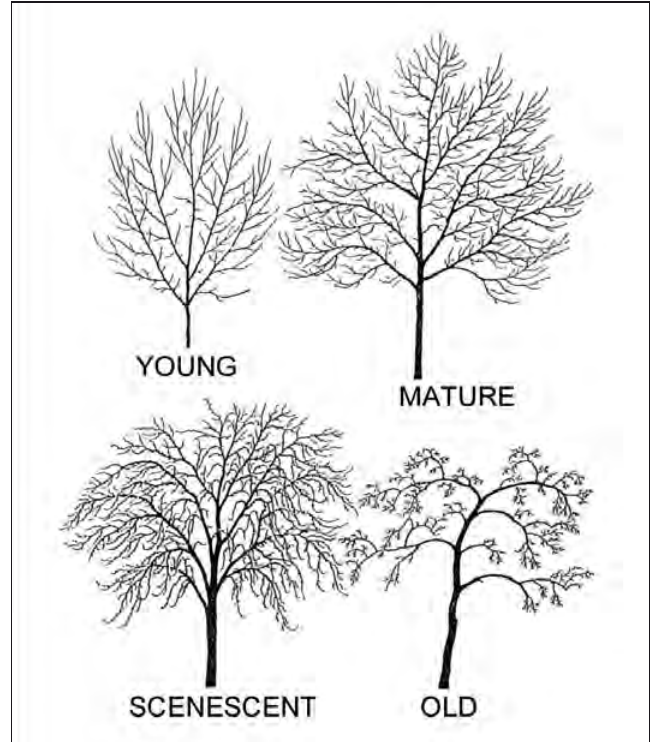
Fig. 1 - Evolution of the tree crown during plant life (from Hilken - bäumer,